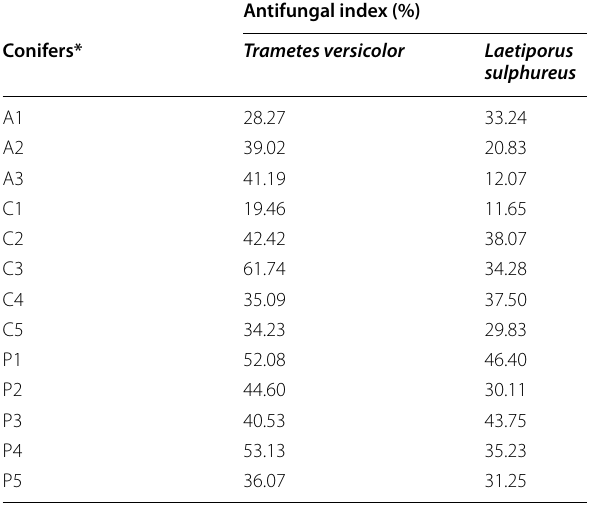
Table 3 Antifungal index of exudates of conifers grown in